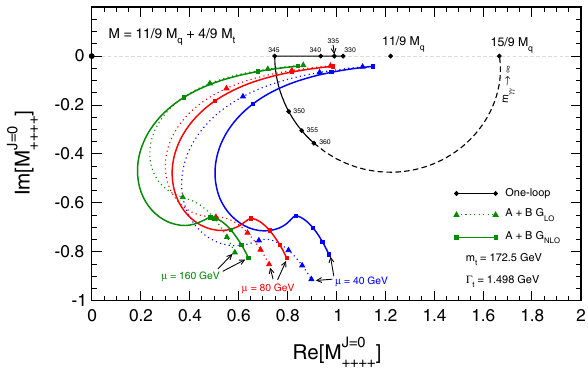
Fig. 2 gg → γγ amplitudes for { λ i } = + + ++ in the J = 0 channel for m γγ = 330–360 GeV with points in a 5-GeV step. For the illustrative convenience, we set m t = 172 . 5 GeV in this plot